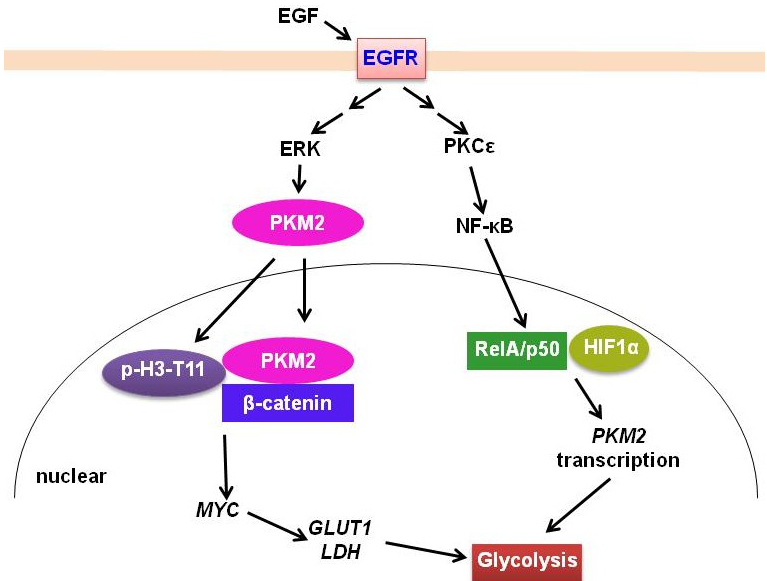
Figure 2. EGFR signaling regulation of PKM2 in gliomas. EGFR signaling promotes PKM2 translocation to nucleus after phosphorylation by ERK. PKM2 then phosphorylates histone H3-T11 and binds to β-catenin to promote MYC expression. MYC stimulates GLUT1